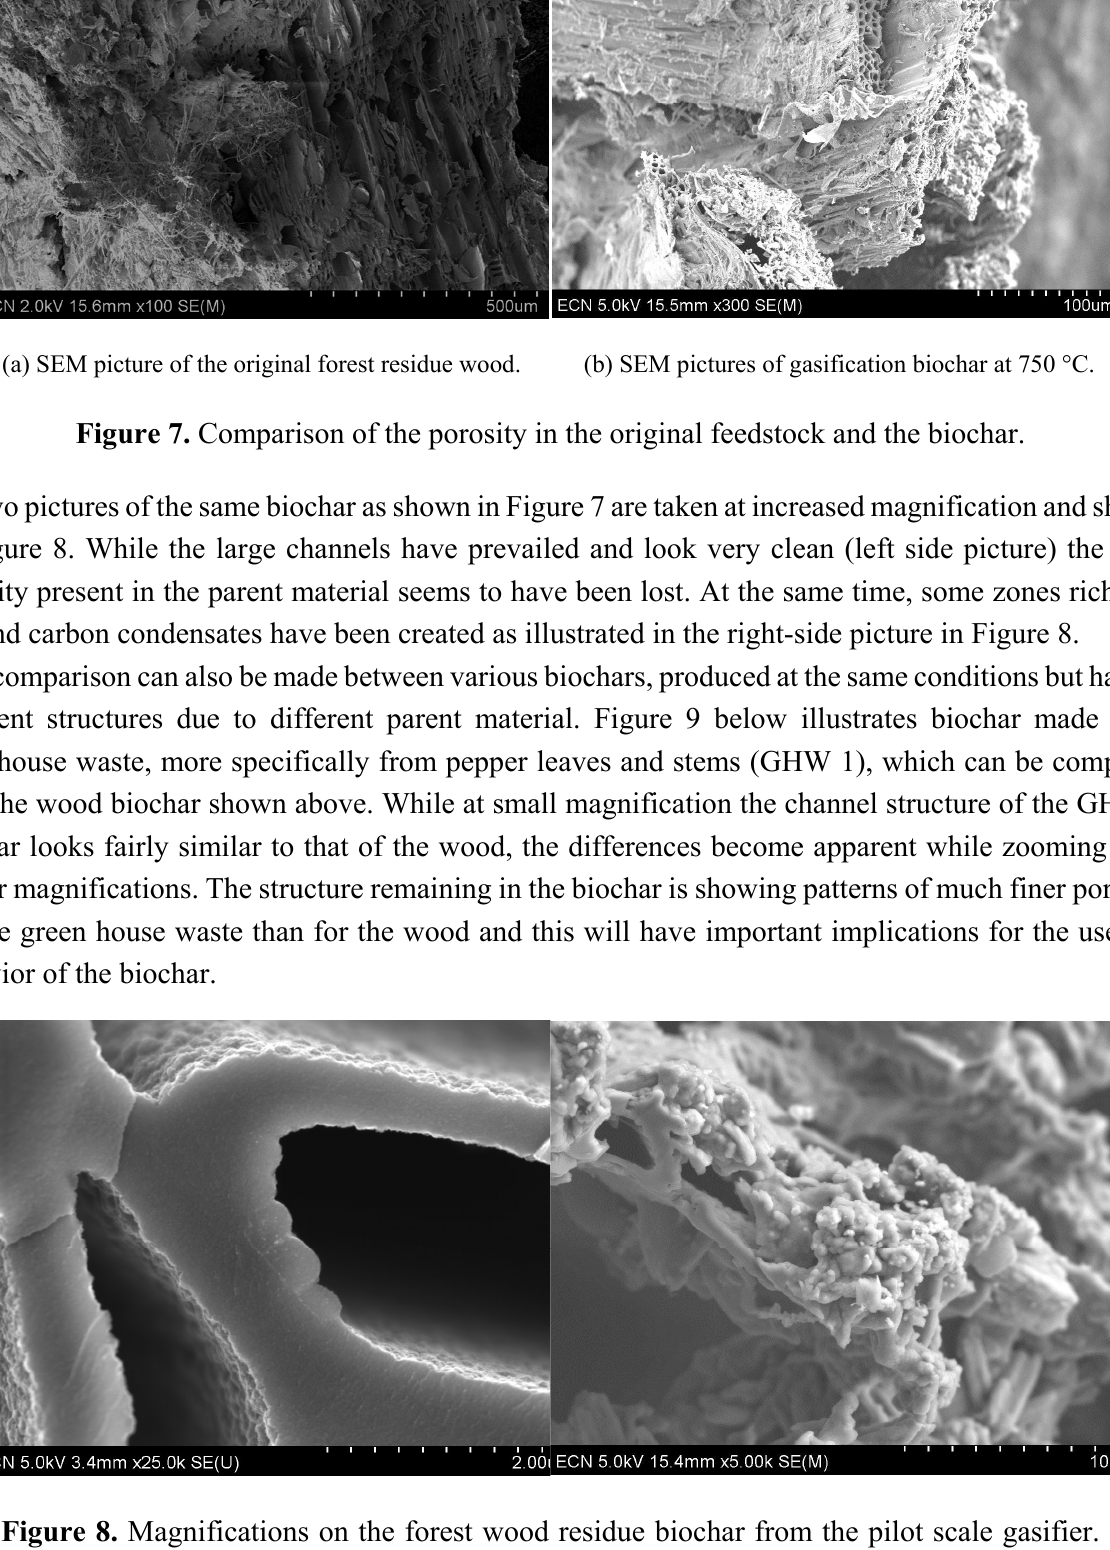
Figure 8. Magnifications on the forest wood residue biochar from the pilot scale gasifier. On the left-hand side the very clean large channel structure and on the right-hand side a zone with some condensed ash and